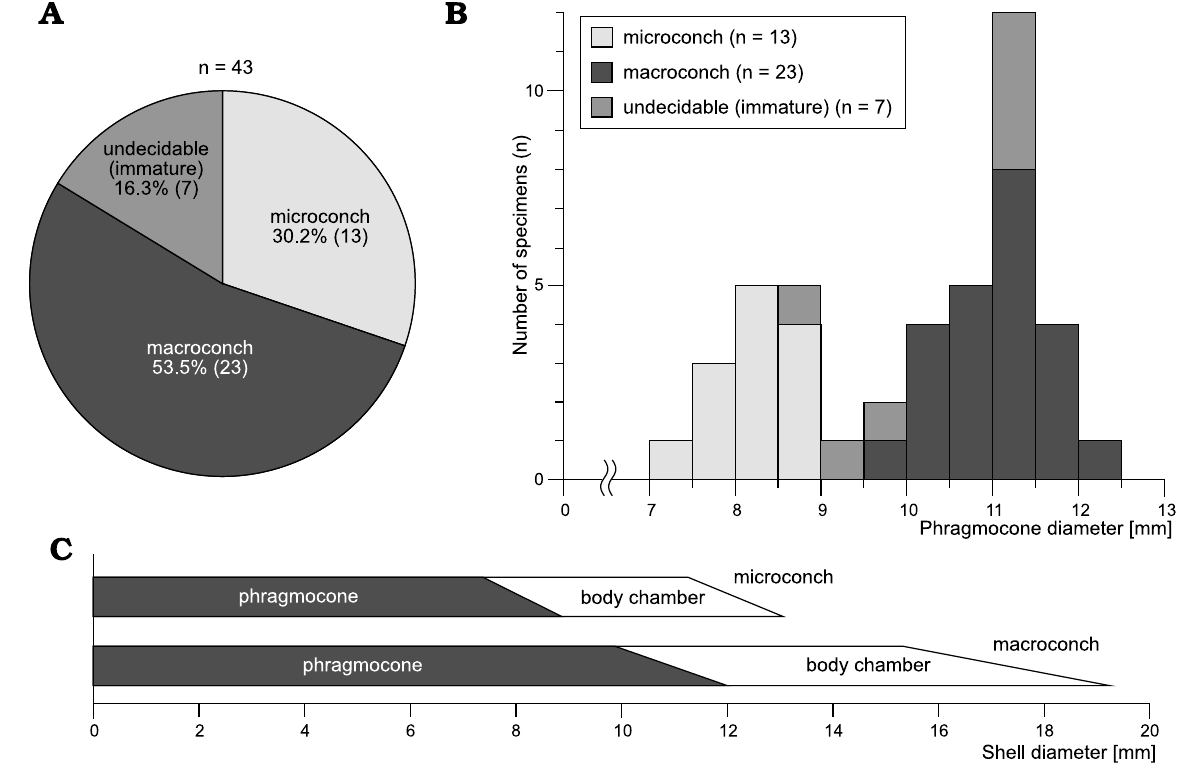
Fig. 5. Characteristics of ratio of numbers and size of dimorphism in tetragonitid ammonoid Tetragonites minimus Shigeta, 1989, from the Yezo Group in Hokkaido, Japan. The specimens treated here were collected from various stratigraphic levels in the Santonian in the Kotanbetsu, Tappu, and Haboro areas. A . The ratio of numbers of dimorphic pairs. B . Compilation of the size distribution in phragmocone diameter (PD). C . Comparative representation of the size of dimorphic pairs with indication of the phragmocone and body chamber.